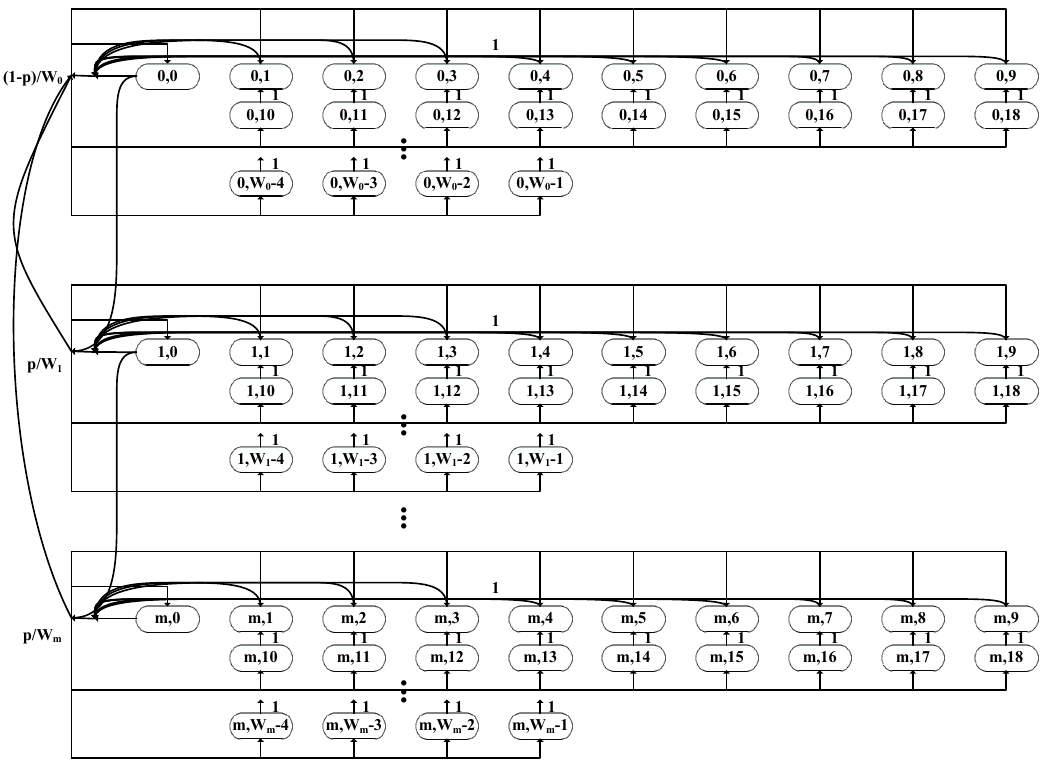
Figure 8. Markov chain model of UORA channel access with 9 resource units (RUs).